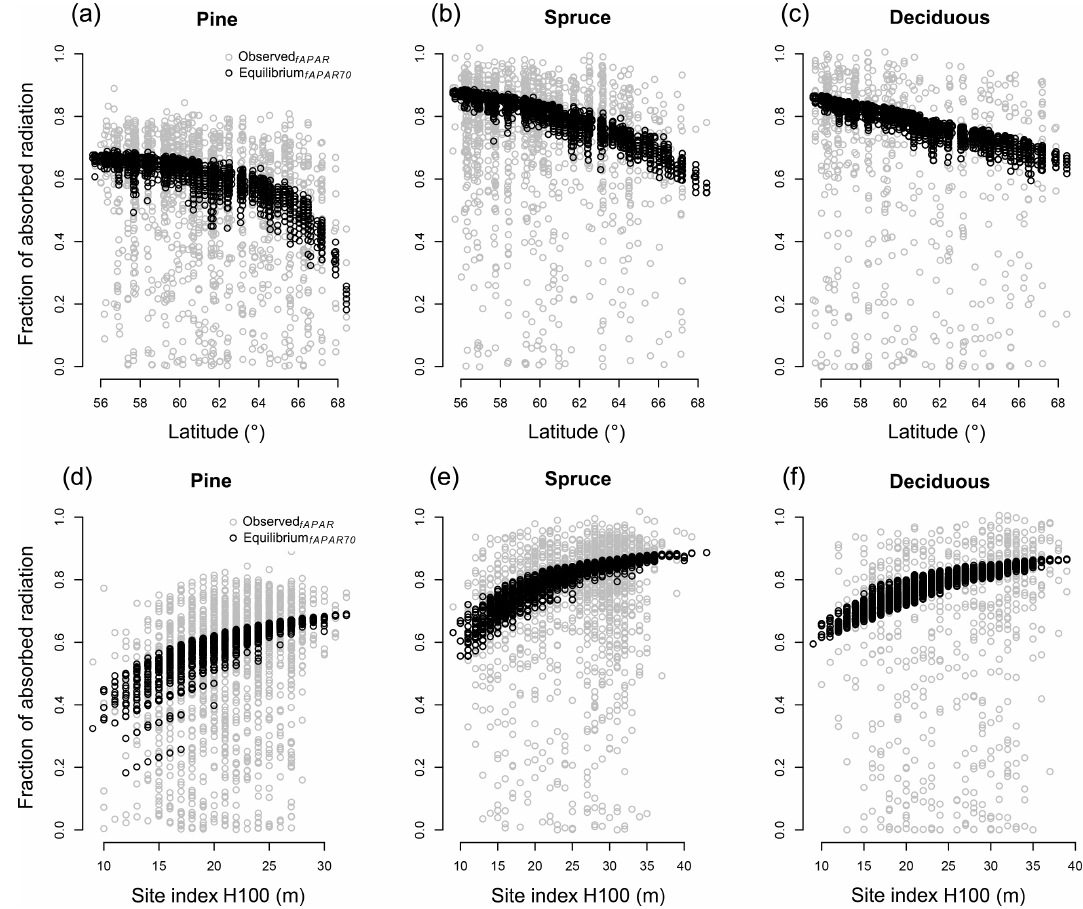
Figure A1. The fraction of photosynthetically active absorbed radiation ( f APAR ; estimated as in Härkönen et al., 2010) observed f APAR and equilibrium f APAR ( f APAR70 , set to 70th percentile of maximum f APAR for given species, latitudinal degree, and site productivity index). Panels (a) , (b) , and (c) show relation between f APAR and latitude ( ◦ ) for forest stands dominated by Scots pine, Norway spruce, and deciduous species, whereas panels (d) , (e) , and (f) show relation between f APAR and site index H100 (height of dominant trees at 100 years in